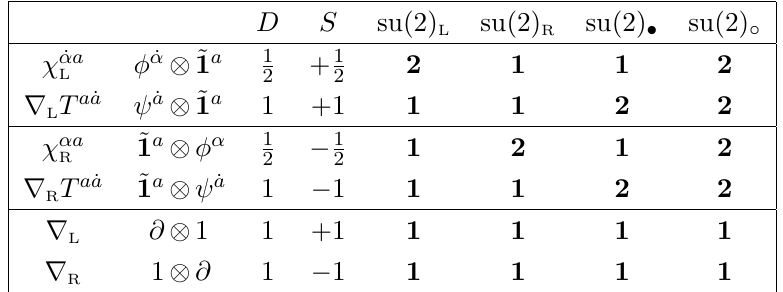
Table 2. The massless fields decomposed as representations of psu(1 , 1 | 2) symbol ˜ 1 a describes an psu(1 , 1 | 2) as a doublet under su(2) ◦